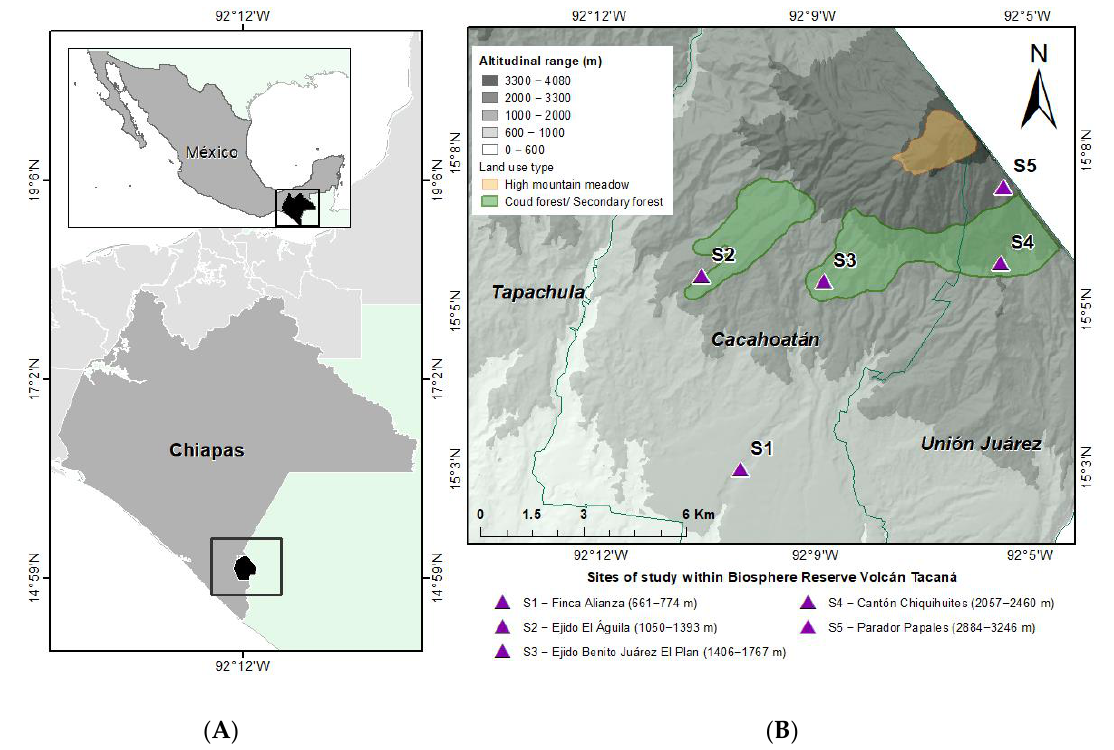
Figure 1. Map of the distribution of sampling sites in the Tacaná Volcano Reserve, Chiapas, Mexico.